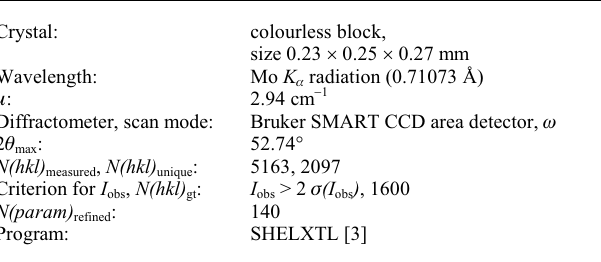
Table 1. Data collection and handling.